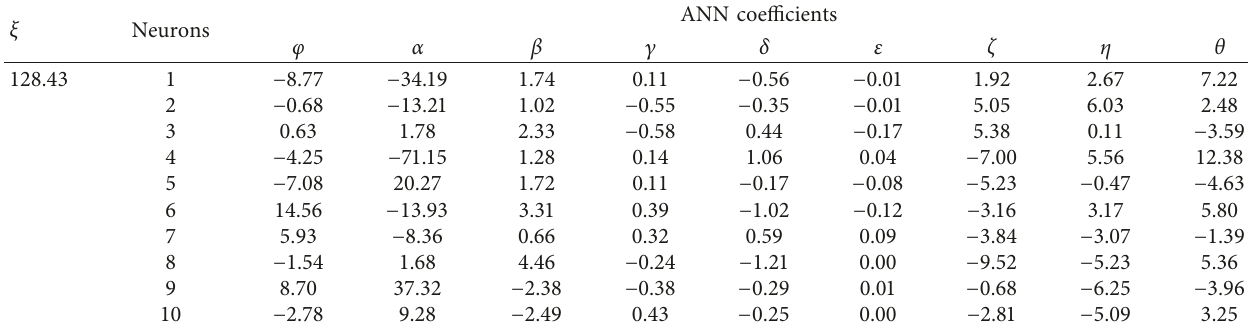
Table 8: ANN coefficients for the Marshall stability prediction model.